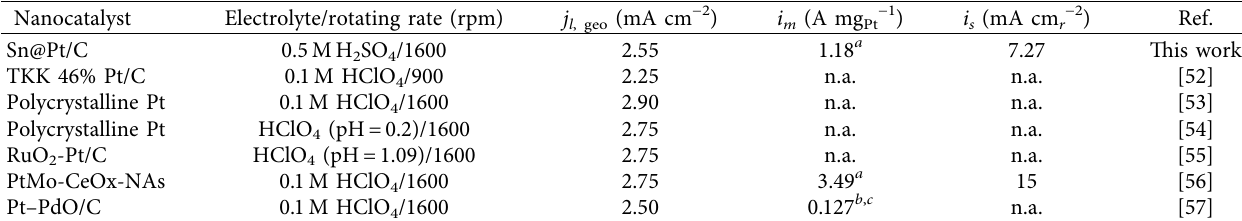
Table 5: Comparison of performance of Sn@Pt/C with those of the literature. Nanocatalyst Electrolyte/rotating rate